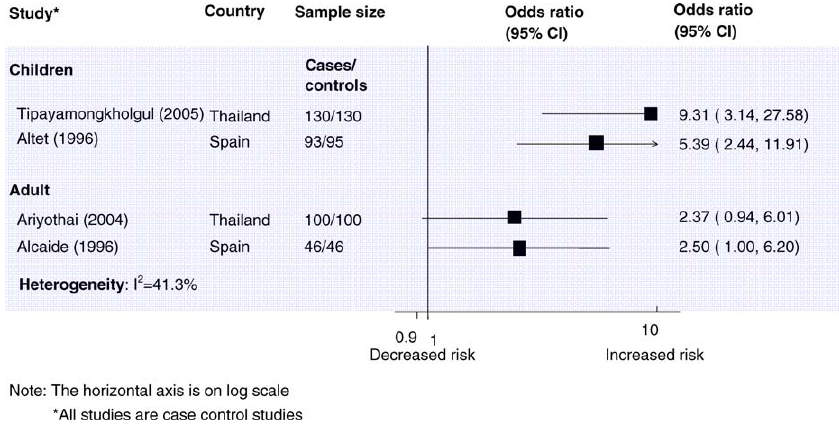
Figure 7. Risk of Clinical TB Disease for Passive Smoking Exposure Compared with Nonexposure